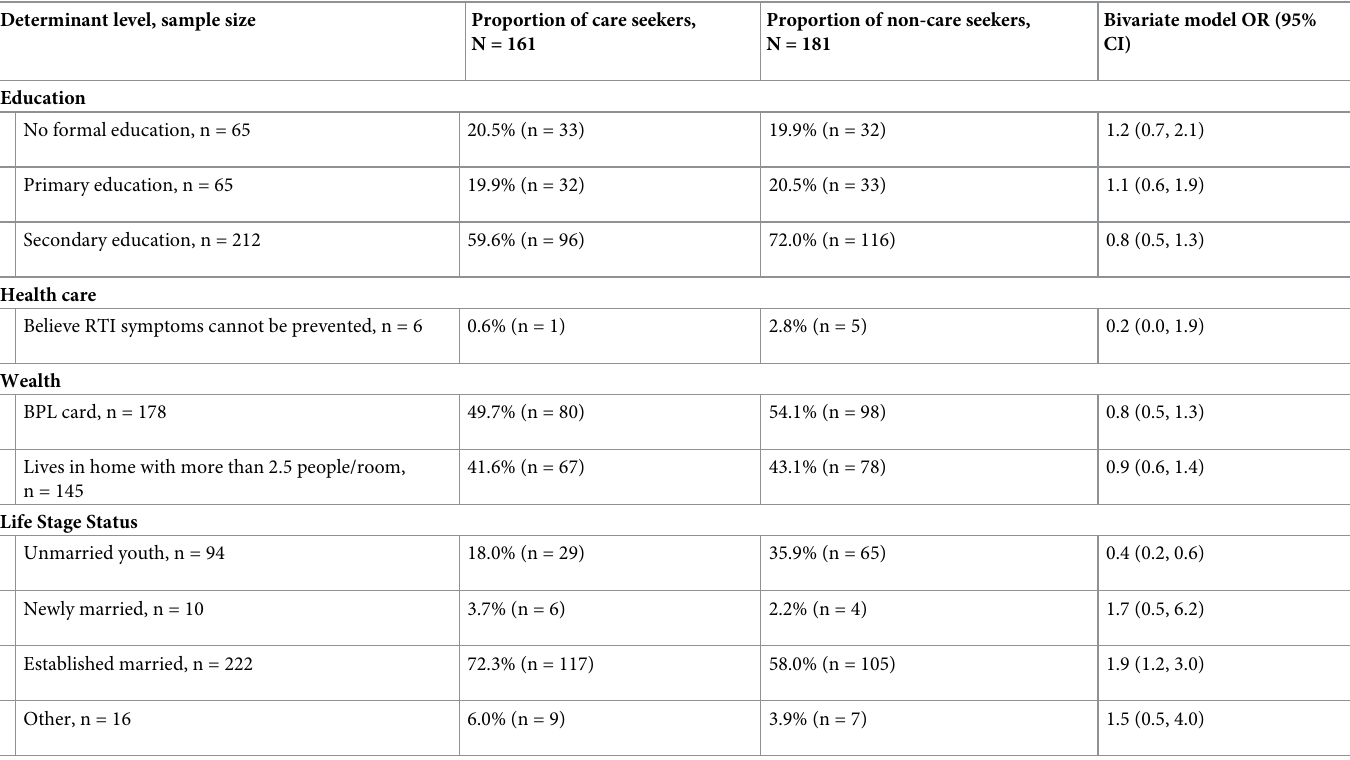
Table 3. Factors associated with health care utilization for RTI symptoms among symptomatic women.